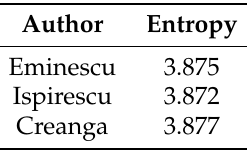
Table 3. Entropy of Romanian